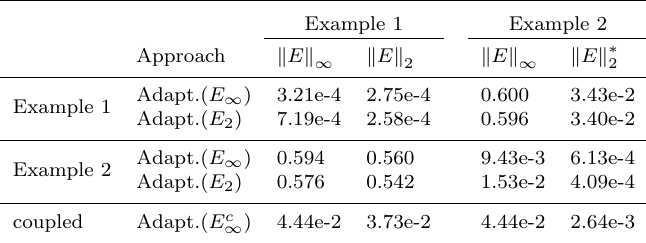
Table 7. Cross-check of the accuracy for different examples Example 1 Example